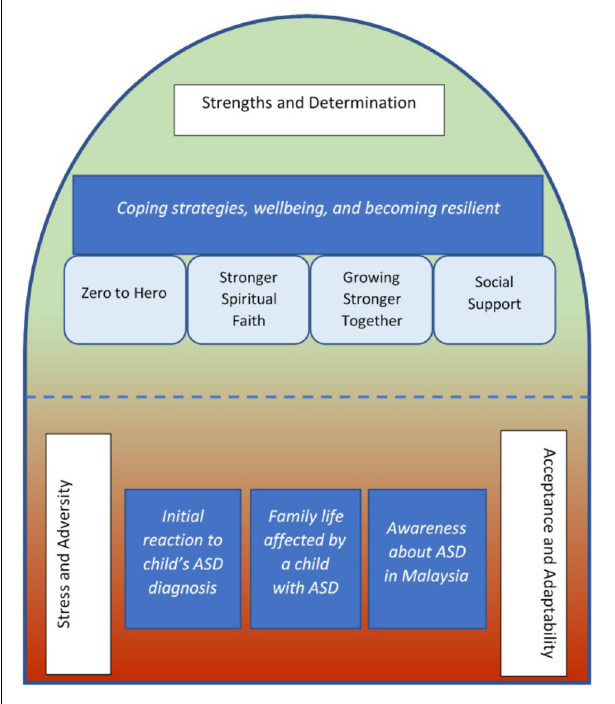
FIGURE 1 | The dynamic mechanisms of resilience in parents of children in the Malaysian